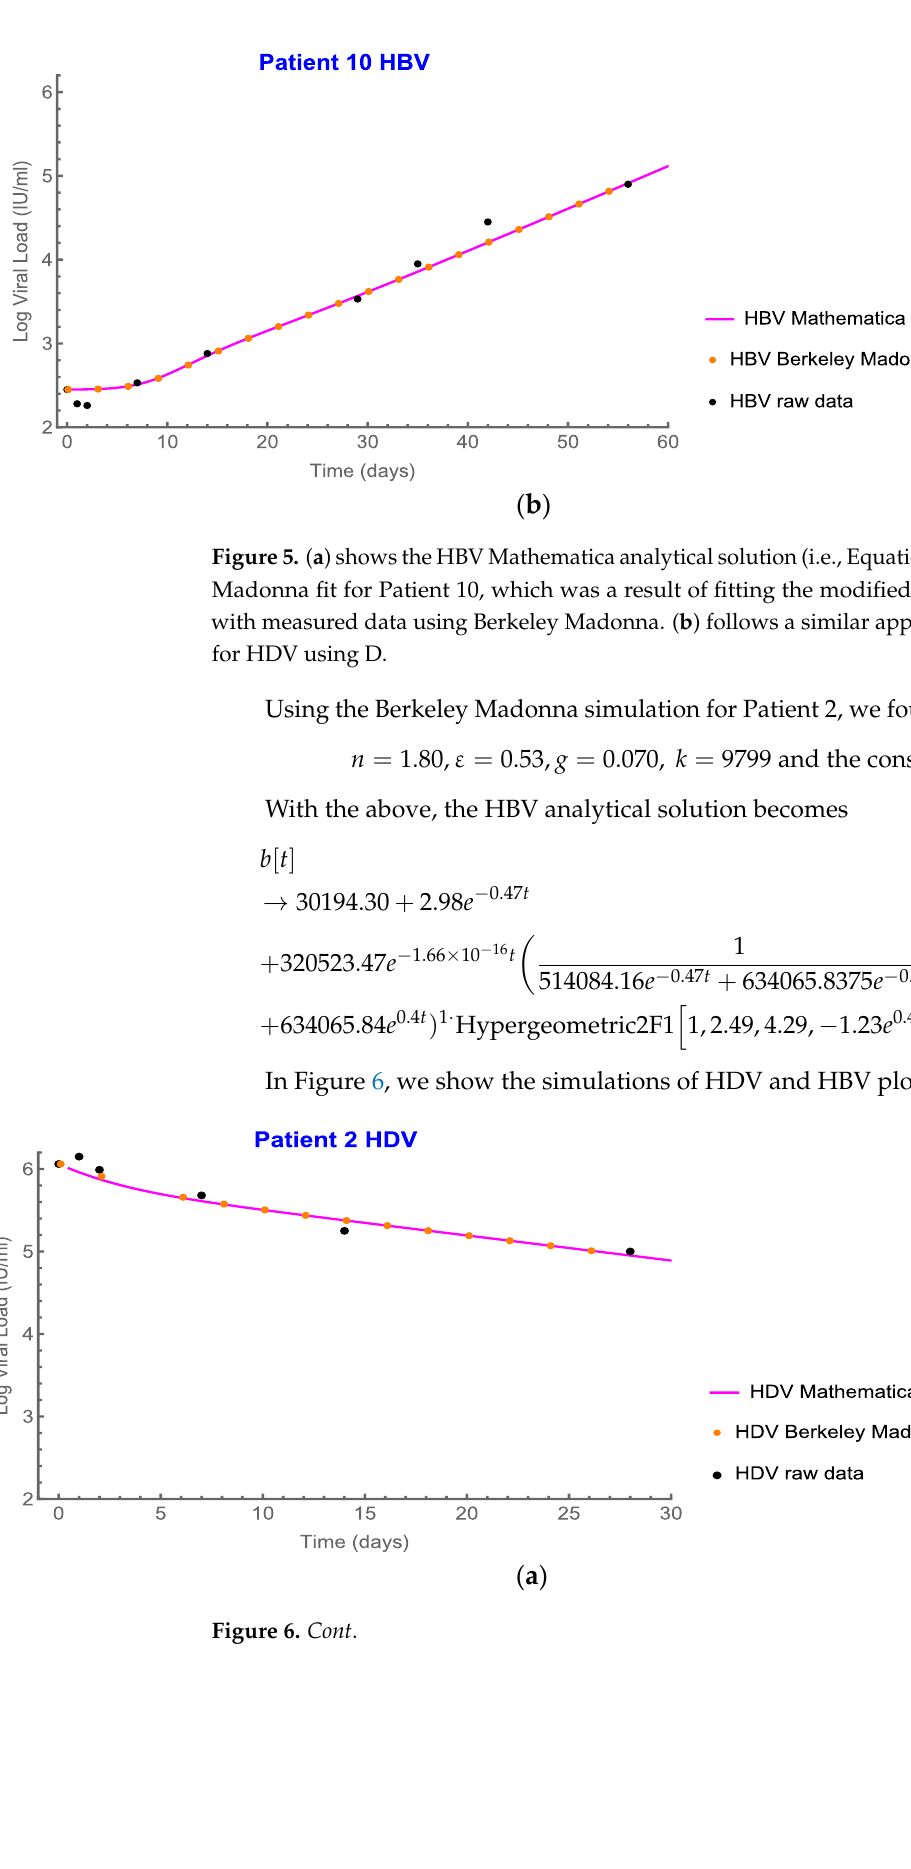
( b ) Figure 6. ( a ) shows the HBV Mathematica analytical solution (i.e., Equation (14) herein), HBV Berke- ley Madonna fit for Patient 2, which was a result of fitting the modified model with measured data using Berkeley Madonna as reported in [4] and the HBV raw data. ( b ) follows a similar approach as conducted in 6a but for HDV using D. Using the Madonna simulation for Patient 4, we found its best-fit parameters: 𝒏 = 𝟐. 𝟎𝟎, ɛ = 𝟎. 𝟗𝟕, 𝒈 = 𝟎. 𝟎𝟓𝟒, 𝒌 = 𝟐𝟓𝟓𝟎𝟑 𝐚𝐧𝐝 𝐭𝐡𝐞 𝐜𝐨𝐧𝐬𝐭𝐚𝐧𝐭 𝒄 = 𝟎. 𝟒𝟕 With the above, the HBV analytical solution becomes